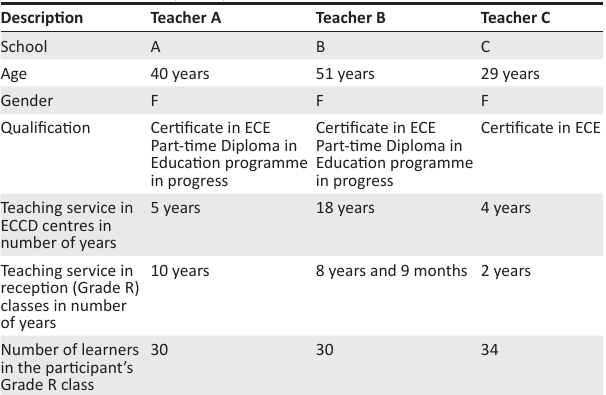
TABLE 1: Profile of the